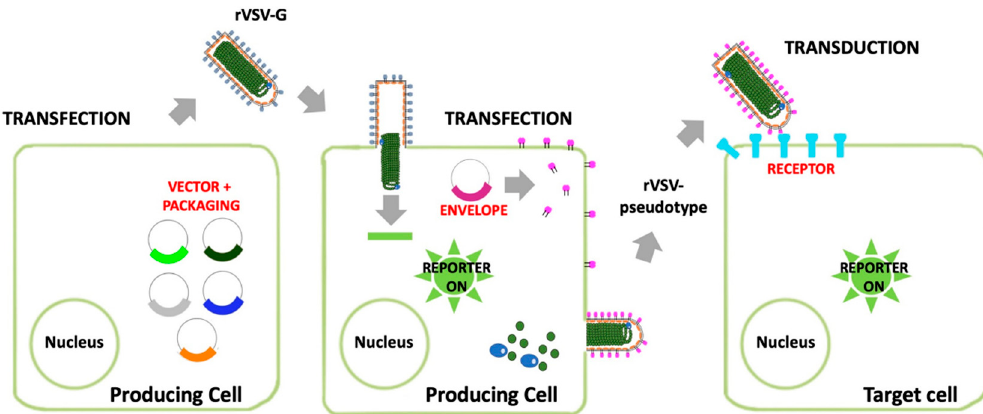
Figure 2. Recovery, growth and pseudotyping of rVSV- ∆ G-GFP. The system is based on a plasmid encoding the viral genome, containing a reporter gene (GFP) instead of the native gene coding for the glycoprotein G, and four plasmids providing the packaging system (matrix M, polymerase L, phosphoprotein P and G). At the beginning, cells are cotransfected with the pVSV- ∆ G-GFP plasmid along with the four packaging plasmids to recover the G-complemented rVSV- ∆ G-GFP. To express the viral genome for the first viral rescue, a plasmid encoding the T7 RNA polymerase is also required (not shown). This virus can be used for the generation of a pseudotyped rVSV- ∆ G-GFP by transducing cells preventively transfected with a plasmid encoding for the heterologous glycoproteins. Then, the pseudotyped virus can be used to transduce target cells.